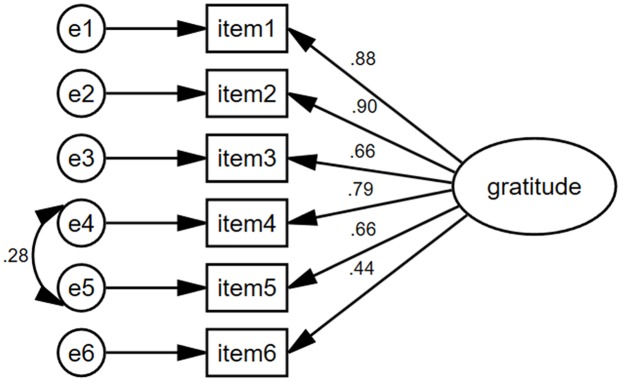
The structure model of the Gratitude Questionnaire.